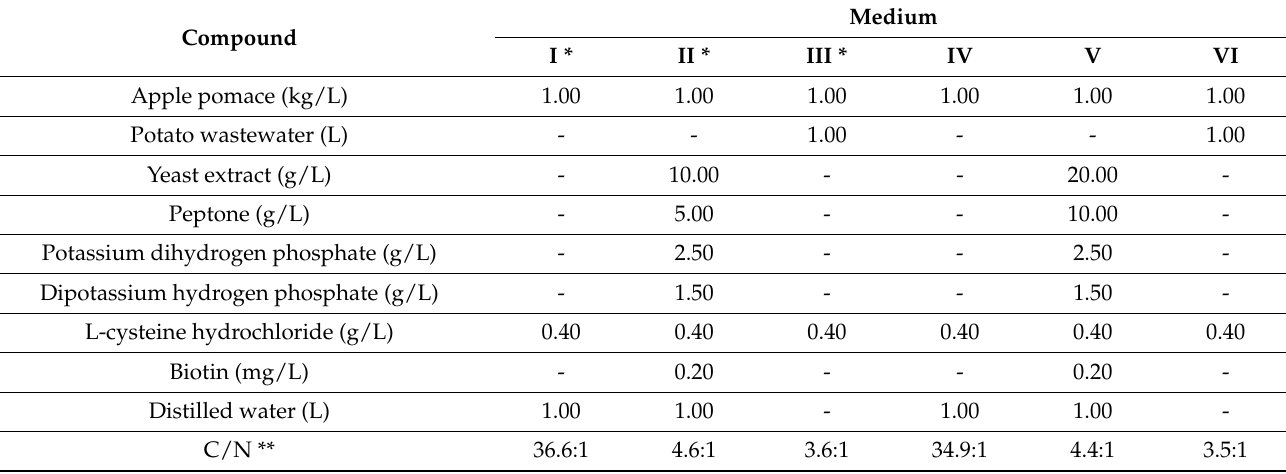
Table 3. Composition of